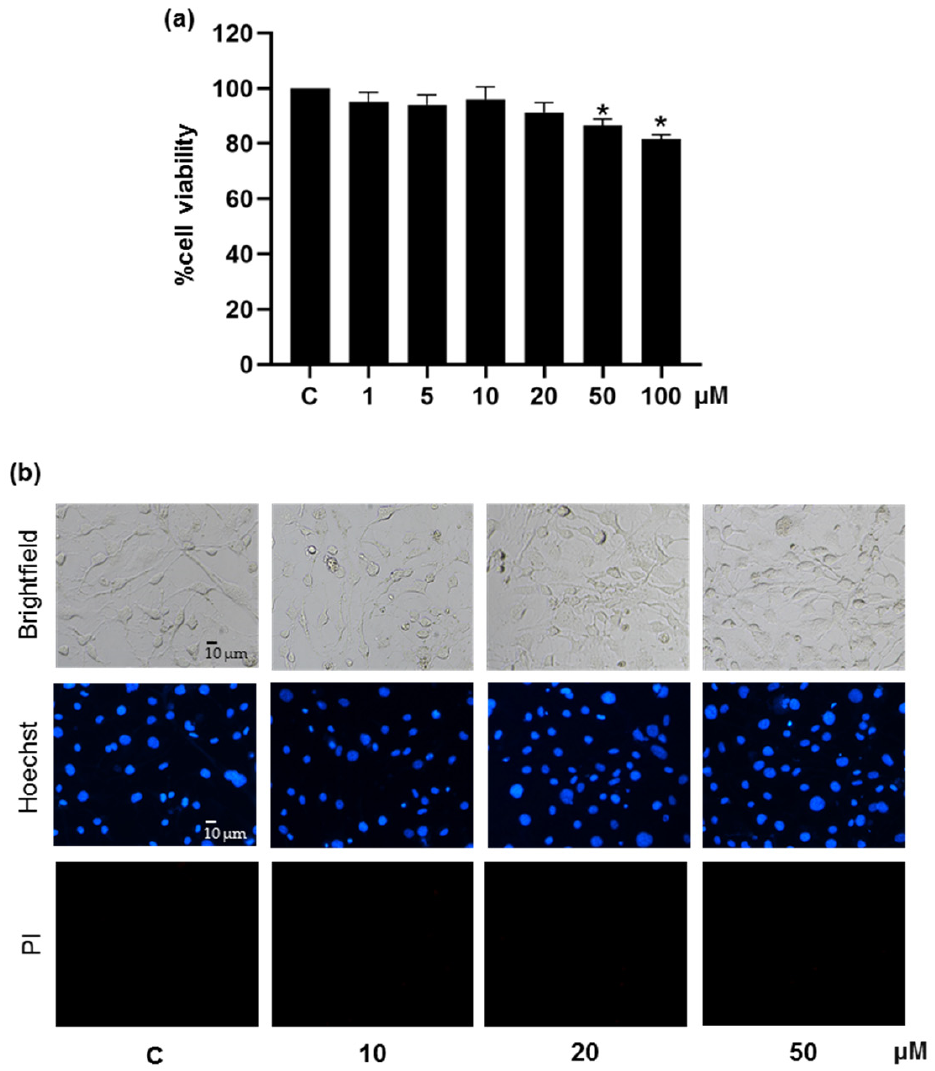
Figure 2. Cytotoxicity of pinostrobin in mouse 3T3-L1 pre-adipocytes accessed via ( a ) crystal violet viability assay and ( b ) Hoechst33342 (Hoechst) and propidium iodide (PI) co-staining for detecting mode of cell death. Data represents mean ± SD (n = 3). * p < 0.05 compared with vehicle control cells (C) treated with 0.5% DMSO.